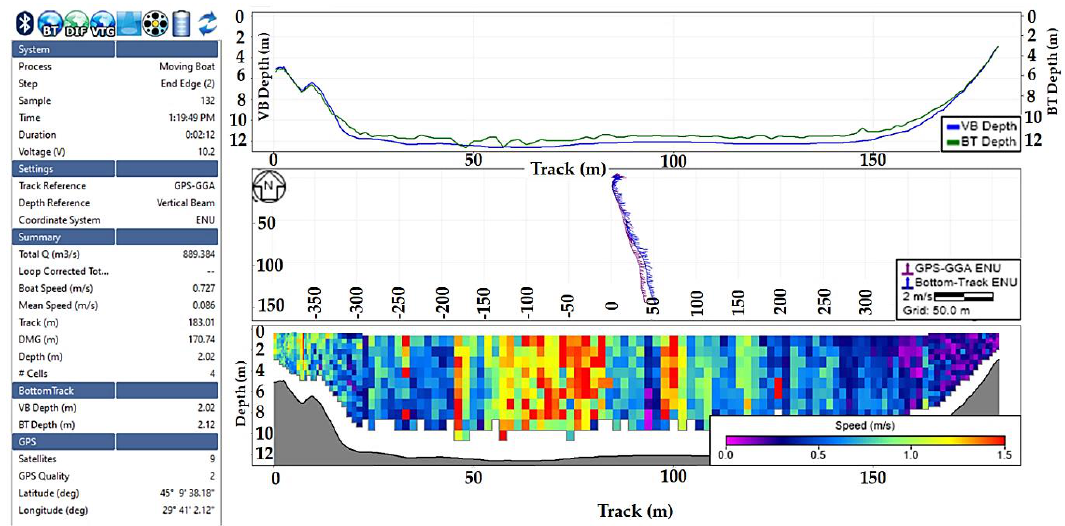
Figure 7. Profile S3 created with the ADCP-profile trajectory, measured parameters (total flow, boat speed, average speed, measured distance, depth) and water velocity graph (velocities distributed on cells, with a colour gradient of velocity intensity, on the water column). The profile was extracted from the River Surveyor Live software (Version 4.1, SONTEK Company, San Diego, CA, USA, 2018) used in the processing of data collected by